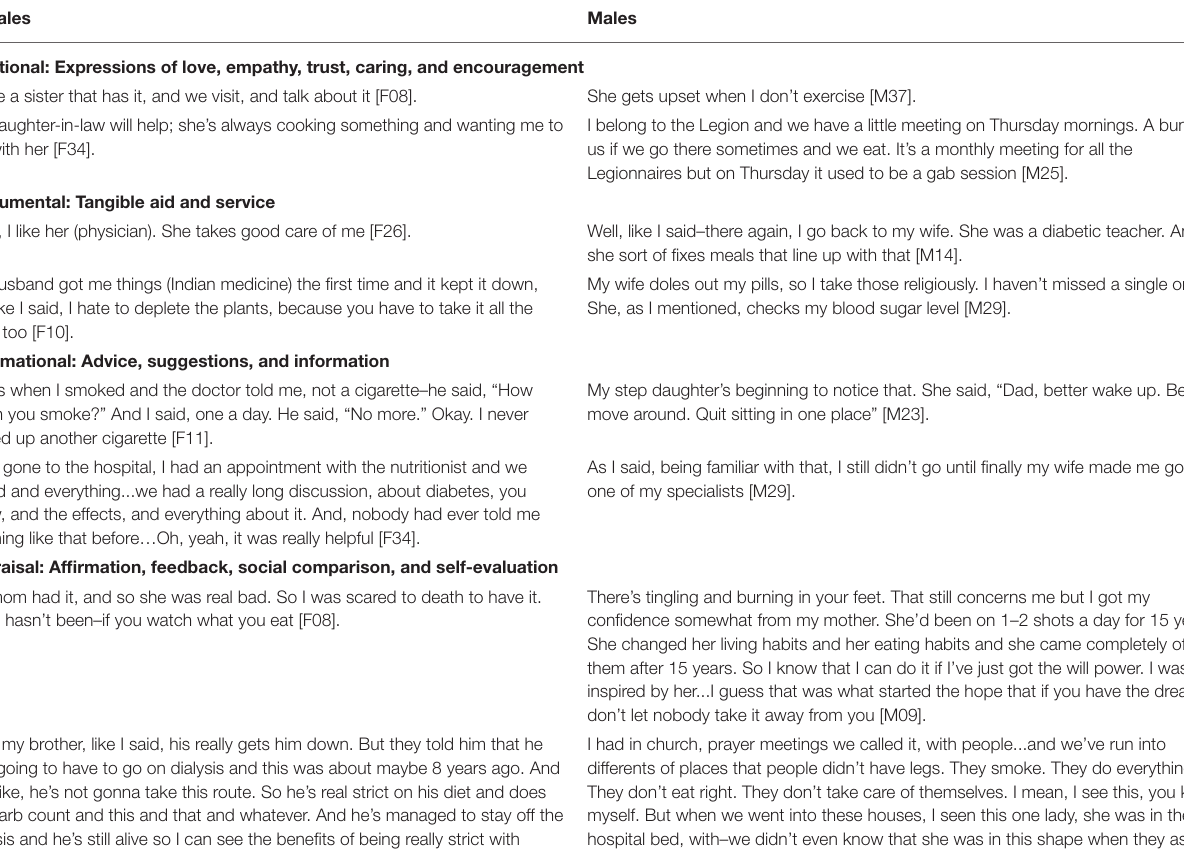
TABLE 3 | Exemplar quotes by types of social support. Females Males